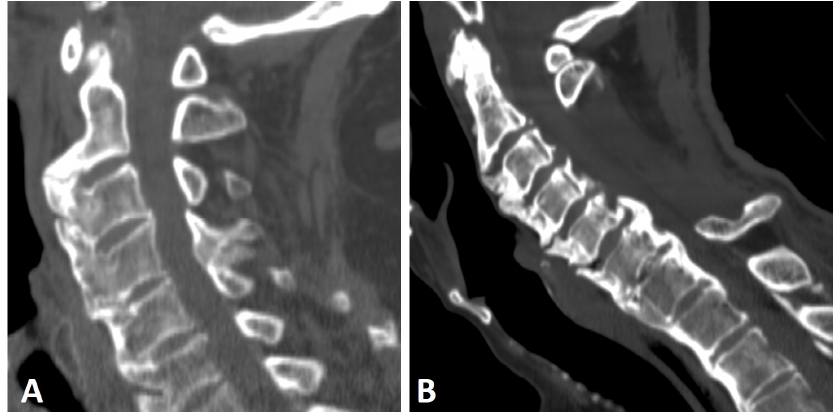
Figure 2. Sagittal CT reconstruction images of two patients with thoracic (not shown) and cervical DISH. ( A ) Flowing chunky osteophytes are located anteriorly to the vertebrae, forming a “candle flame” or “parrot-beak” image. ( B ) Thick, not-yet-flowing anterior osteophytes and thick posterior osteophytes at the C5–6 level.